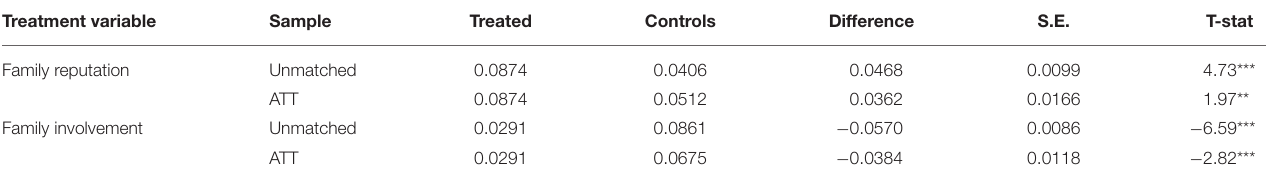
TABLE 4 | PSM estimates of effect of family reputation/family involvement on international business expansion.